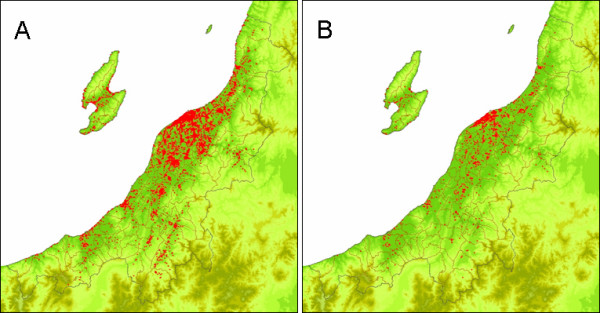
Distribution of residence of inpatients. (A) All inpatients (n = 8,177) admitted to Niigata University Hospital during the period from April 2003 to March 2005 were geocoded to a GIS map of Niigata Prefecture. (B) All inpatients under 15 years of age (n = 1,323) were also plotted on a map.